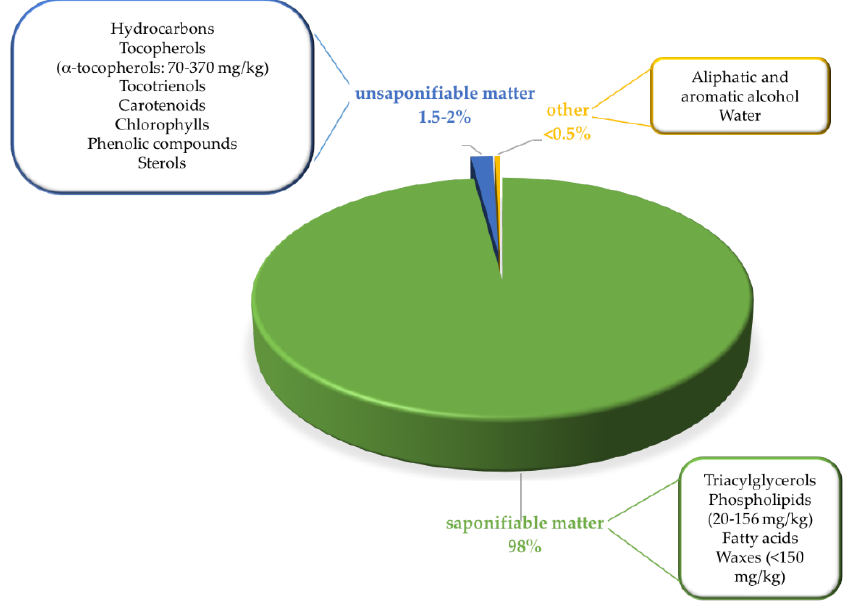
Figure 1. Olive oil composition.